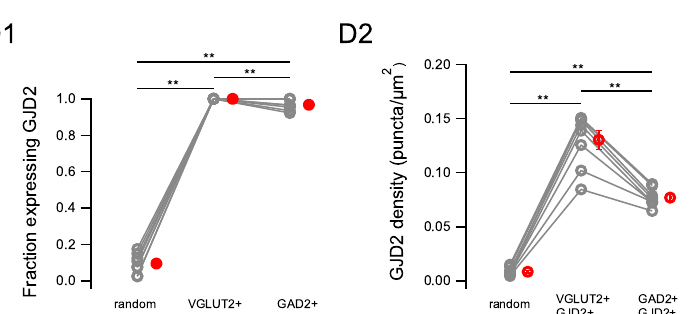
Figure 5. Expression of GJD2 mRNA in nucleus RA from canaries. Extensive expression of GJD2 in GAD2 mRNA- positive and VGLUT2 mRNA-positive neurons. ( A ) RA nucleus overview. ( B1 – B4 ) single confocal plane, magnification of the region highlighted in A. ( C1 – C2 ) Magnified insets from regions highlighted in B4 show a representative VGLUT2 mRNA-positive, GJD2 mRNA-positive cell and a representative GAD2 mRNA-positive, GJD2 mRNA-positive cell. ( D1 ) fraction of cells expressing GJD2 within each population of labeled neurons: VGLUT2-positive and GAD2-positive cells. ‘Random’, randomly drawn ROIs which did not include DAPI staining and which were neither stained for DAPI nor for VGLUT2/GAD2. ( D2 ) GJD2 density in GJD2 mRNA-expressing VGLUT2 and GAD2 mRNA-positive neurons. ** P < 0.01, two-tailed Wilcoxon signed-rank test. Each gray symbol represents the average for one animal. The average values of the same animal for the three types of ROI are linked. Red symbols: average across animals. Error bars: ± S.E.M.